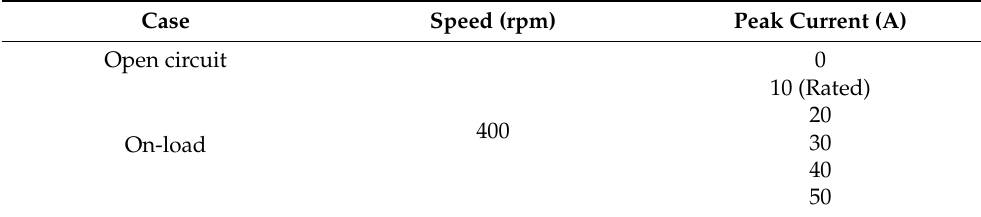
Table 2. Key Design Parameters of Analyzed